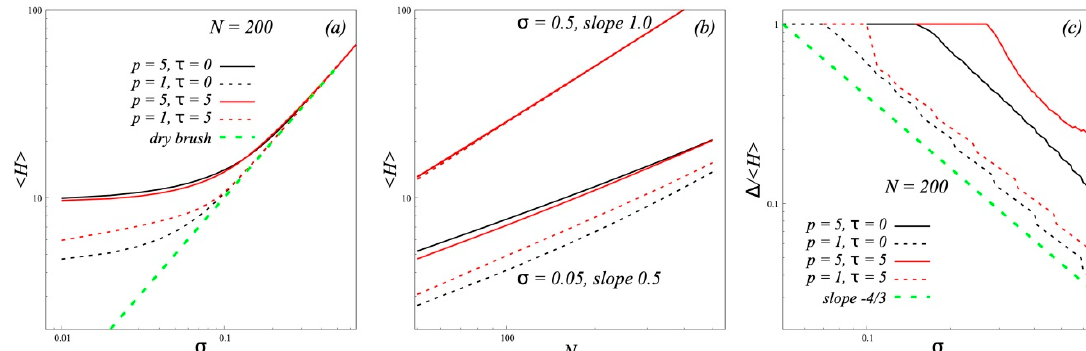
Figure 3. The thickness < H > of brushes with different stiffness of the grafted chains ( p ) and different values of the parameter of dipole-dipole interaction ( τ ) in melt of the same chains. The values < H > are plotted vs the grafting density σ ( a ) and the degree of polymerization N of the grafted chains ( b ). The graph ( c ) shows the ratio of the overlap zone ∆ of free chains with the brush chains to the brush thickness < H > . All graphs are plotted in log-log coordinates.